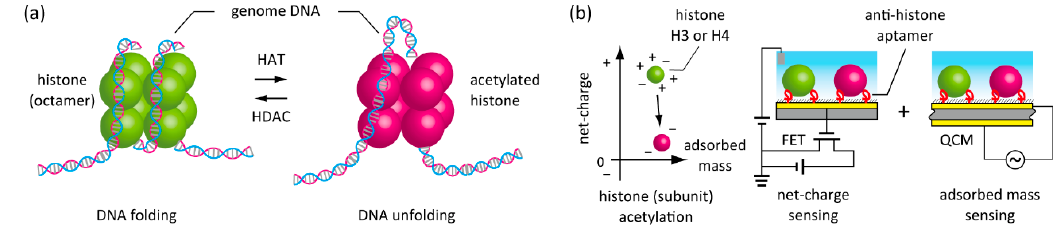
Figure 1. Schematics showing in situ label-free detection of histone acetylation. ( a ) Enzymatic acetylation and deacetylation of histone in the cell nucleus for the regulation of gene transcription. ( b ) A new strategy to detect histone acetylation through the measurements of net-charge and adsorbed mass using aptamer-functionalized field-effect transistor (FET) and quartz crystal microbalance (QCM) biosensors in parallel.